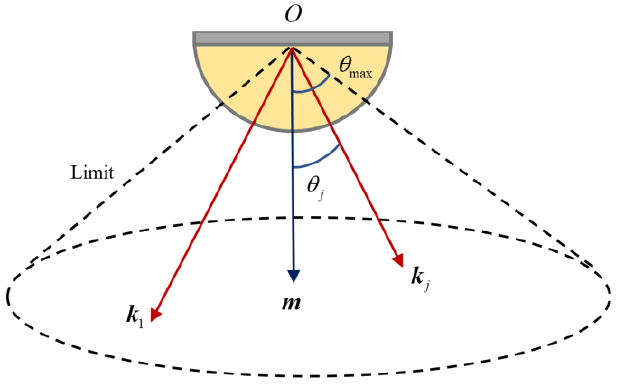
Figure 3. Incidence angle limitation of the target